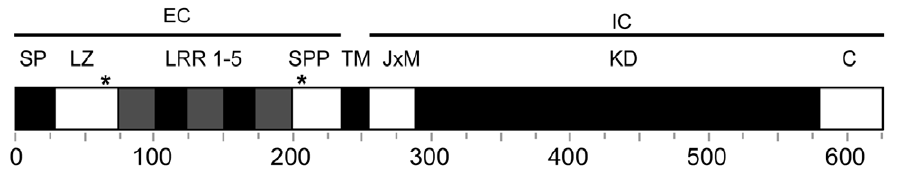
Figure 1. Domain architecture of SERK1. SP=signal peptide, LZ=leucine zipper, LRR=leucine-rich-repeats, SPP=serine-proline rich domain, TM=single pass transmembrane domain, JxM=juxtamembrane domain, KD=kinase domain, C=C-terminal tail, EC=extracellular domain, and IC=intracellular domain. Two cysteine pairs in the extracellular domain are depicted with *, and numbers below the graph indicate amino acid